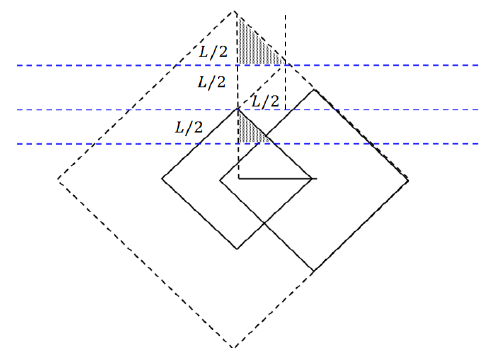
Figure 12. Maximum length for approximation